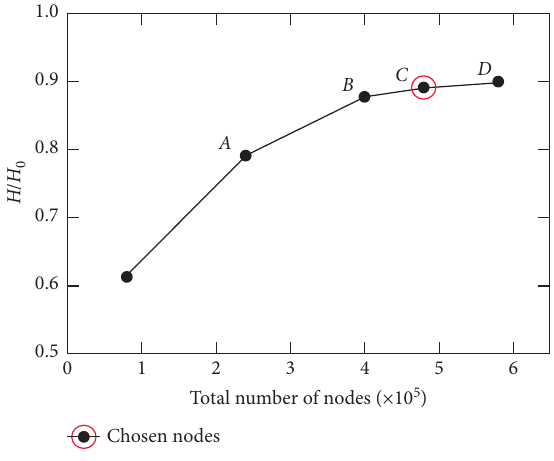
Figure 1: Mesh independence test.